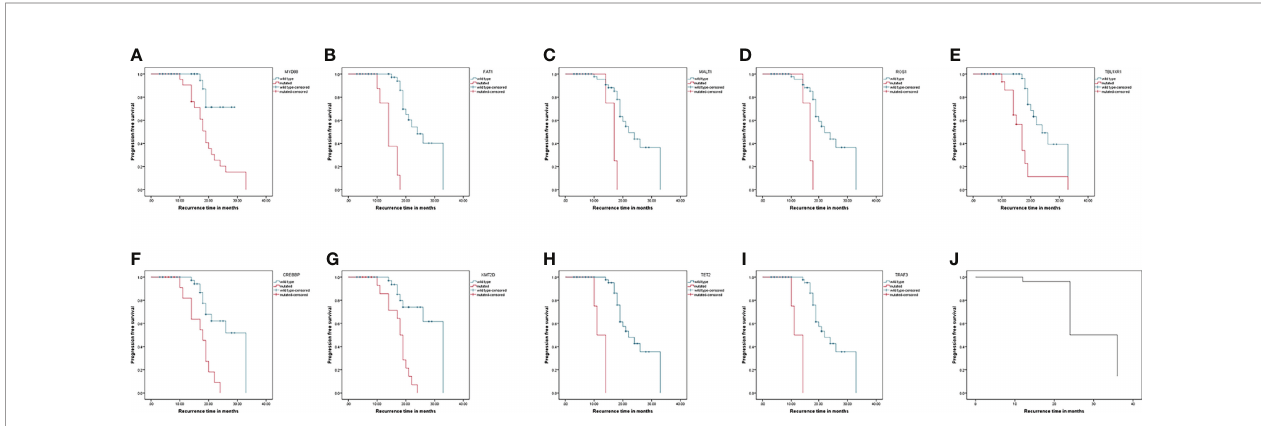
FIGURE 4 | Progression-free survival curves of patients with lymphoma. Kaplan-Meier curves for progression-free survival by presence or absence of genes mutation. (A – I) was genes: MYD88, FAT1, MALT1, ROS1, TBL1XR1, CREBBP, KMT2D, TET2, and TRAF3. (J) was the progression-free survival curve for all